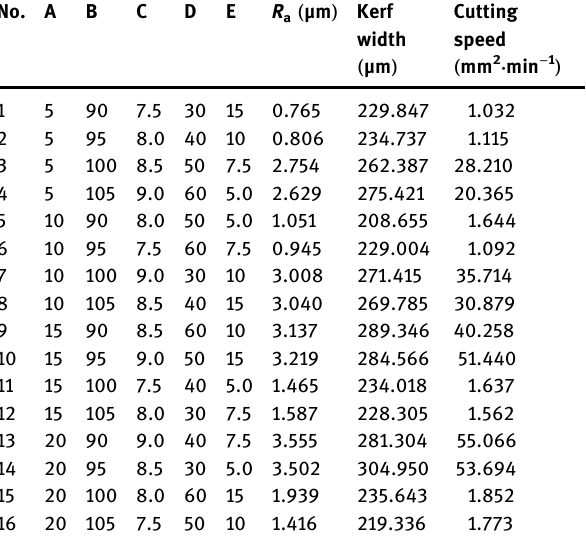
Table 4: The test results of the orthogonal table Table 5: Orthogonal table test results using dimension normaliza - tion